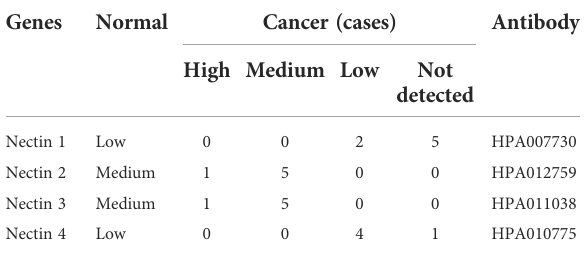
TABLE 2 Immunohistochemical stains of nectin protein obtained from the Human Protein Atlas in normal liver tissues and hepatocellular carcinoma